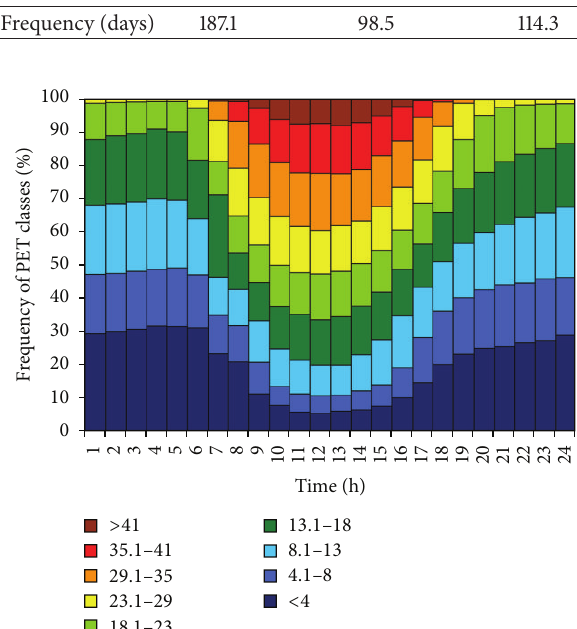
Figure 2: Bioclimatic diagram for Athens University Campus for the period 1999–2007; frequencies (%) of the nine PET classes for each hour of the mean day.